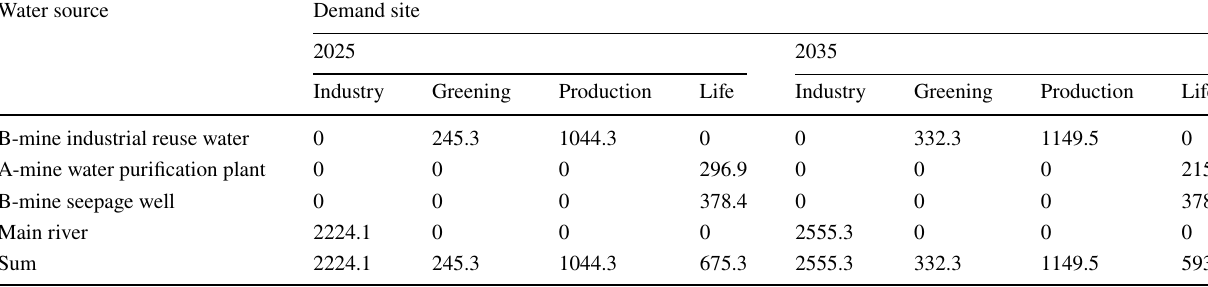
Table 6 Results of water resources allocation in the b-mine area in 2025 and 2035